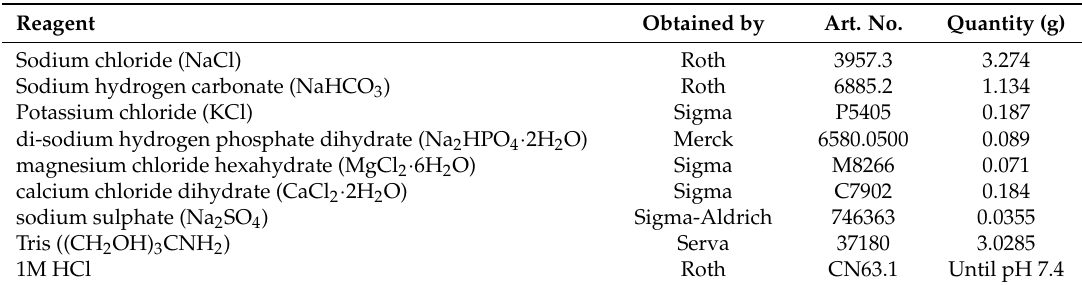
Table 8. Composition of Tris-buffered SBF